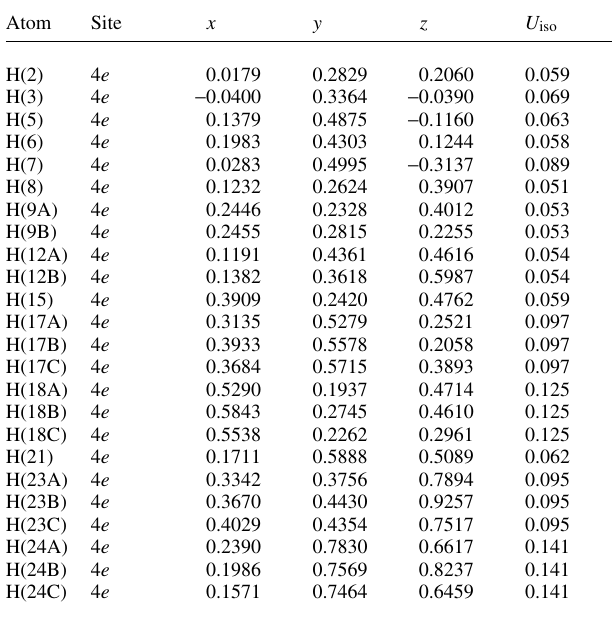
Table 2. Atomic coordinates and displacement parameters (in Å 2 ) .